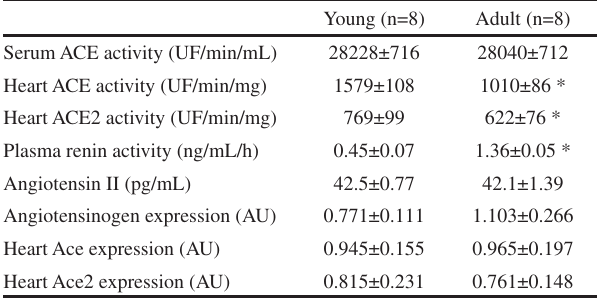
Table 3 - Expression and activity of renin-angiotensin system